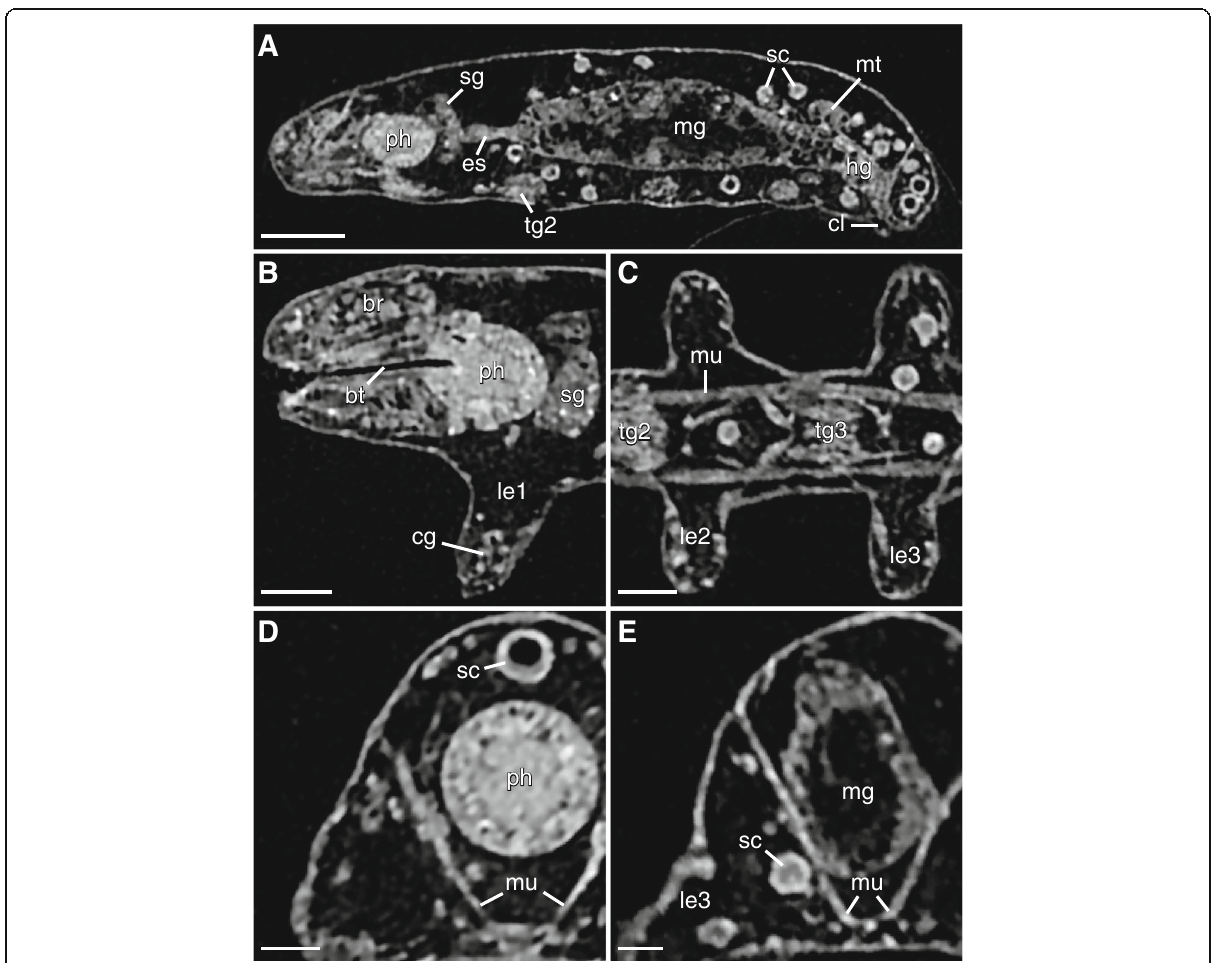
Fig. 3 NanoCT slices of the tardigrade Hypsibius exemplaris . Anterior is left (in a - c ), dorsal is up (in all images except for c ). The slices have a voxel size of 270 nm (in a , c and e ), and 200 nm (in b and d ), respectively. a Sagittal view through the midline of the body showing the digestive tract. The transition between the midgut and hindgut is marked by the attachment sites of the Malpighian tubules. b Sagittal view through the head region showing the pharynx and the lumen of the buccal tube. c Horizontal view through the ventral body (at the level of the ganglia) showing the second and third leg pairs. The trunk ganglion in each segment lies anterior to the legs of the same segment. Notice the thick ventral longitudinal muscles. d Transverse view through the head region showing the pharynx, a large storage cell, and paired dorsoventral muscles. e Transverse view through the third trunk segment showing the large midgut and paired dorsoventral muscles. Notice how the storage cell labeled in e shows a relatively homogeneous gray value while that in d appears hollow. Abbreviations: br, brain; bt, buccal tube; cg, claw gland; cl, cloaca; es, esophagus; hg, hindgut; le1 – le3, legs one to three; mg, midgut; mt, Malpighian tubules; mu, muscle; ph, pharynx; sc, storage cells; sg, salivary glands; tg1 – tg2, trunk ganglia one and two. Scale bars: 20 μ m (in a ), 10 μ m (in b and c ), 5 μ m (in d and e